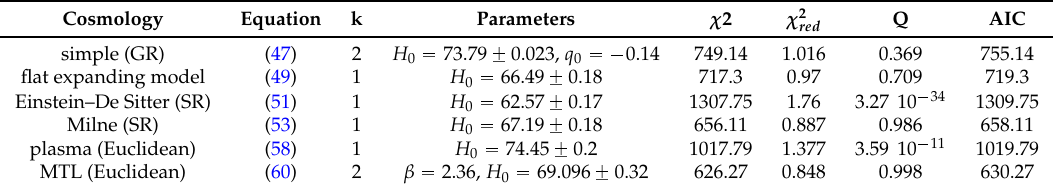
Table 6. Numerical values of χ 2 , χ 2 stands for the number of parameters; H 0 is expressed in kms (cid:1) 1 Mpc (cid:1) 1 .